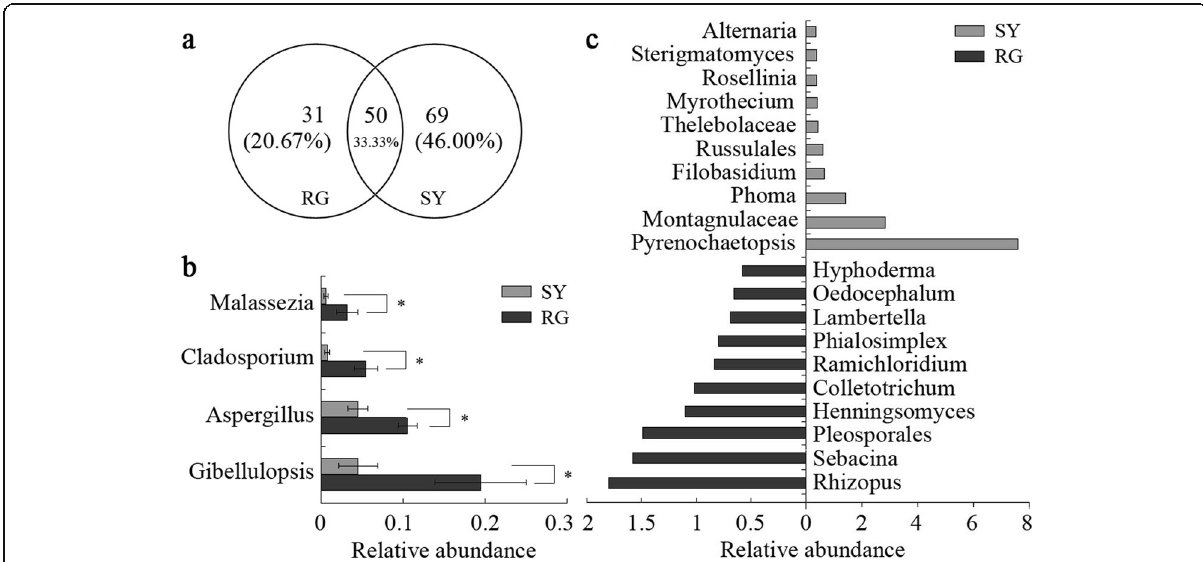
Fig. 4 Comparison of the relative abundance of foliar fungal endophytes between V . vinifera cv. Red Globe (RG) and V . amurensis cv. Shuangyou (SY). a Venn diagram of foliar fungal endophytes recovered from leaves of RG and SY. The numbers of overlapping and non-overlapping fungi at genus level are represented in the circles. b Relative abundance of significantly different genera between RG and SY based on Metastats analysis. Asterisks indicate statistically significant differences ( P < 0.05). c Differentially abundant genera in two